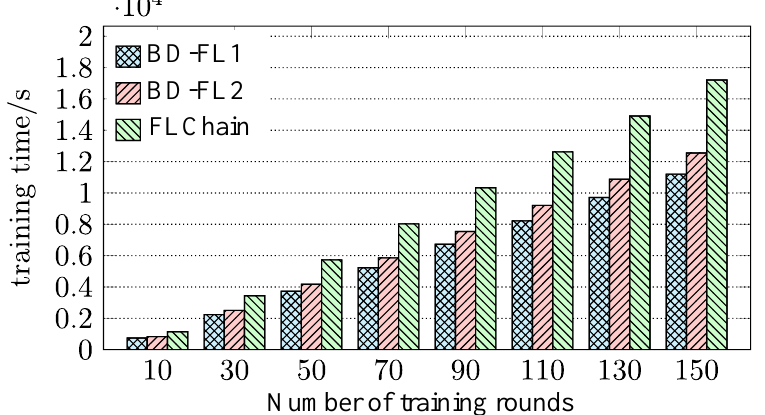
Figure 7. Model training time with different